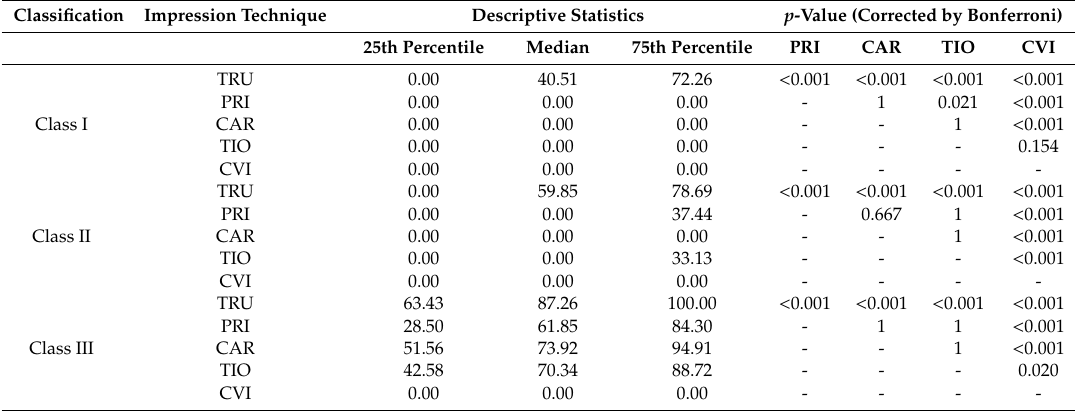
Table 4. Descriptive statistics and results of the Median test corrected by the Bonferroni method for posterior